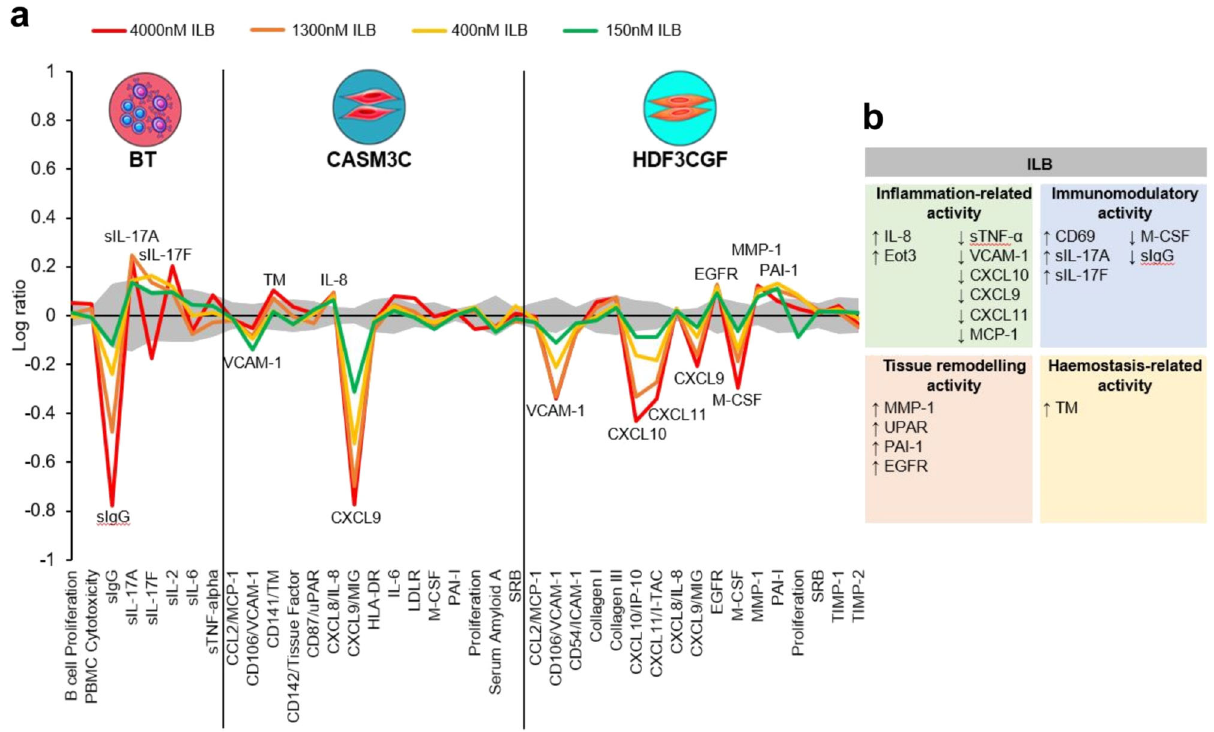
Fig. 1 BioMAP ® Diversity Plus activity pro fi les for ILB ® . ( a ) Log ratio data relating to the cellular and molecular responses of human BT (B cells + peripheral blood mononuclear cells), CASM3C (coronary artery smooth muscle cells) and HDF3CGF (dermal fi broblasts) systems to 150 (green line), 400 (yellow line), 1300 (orange line) and 4000 (red line) nM of ILB ® . The biomarkers assessed in each system are indicated along the x -axis and the grey envelope represents historical vehicle control data at a 95% con fi dence interval. Biomarkers that are deemed to be signi fi cantly altered by ILB ® treatment are annotated on the graph (n = minimum of 6). ( b ) Summary of signi fi cant ILB ® -induced biomarker changes across all 12 BioMAP ® Diversity Plus human cell systems. The changed biomarkers fall into 4 biological activities that are particularly relevant to the observed anti-in fl ammatory and fi brolytic effects of ILB ® and indicate how ILB ® modulated their